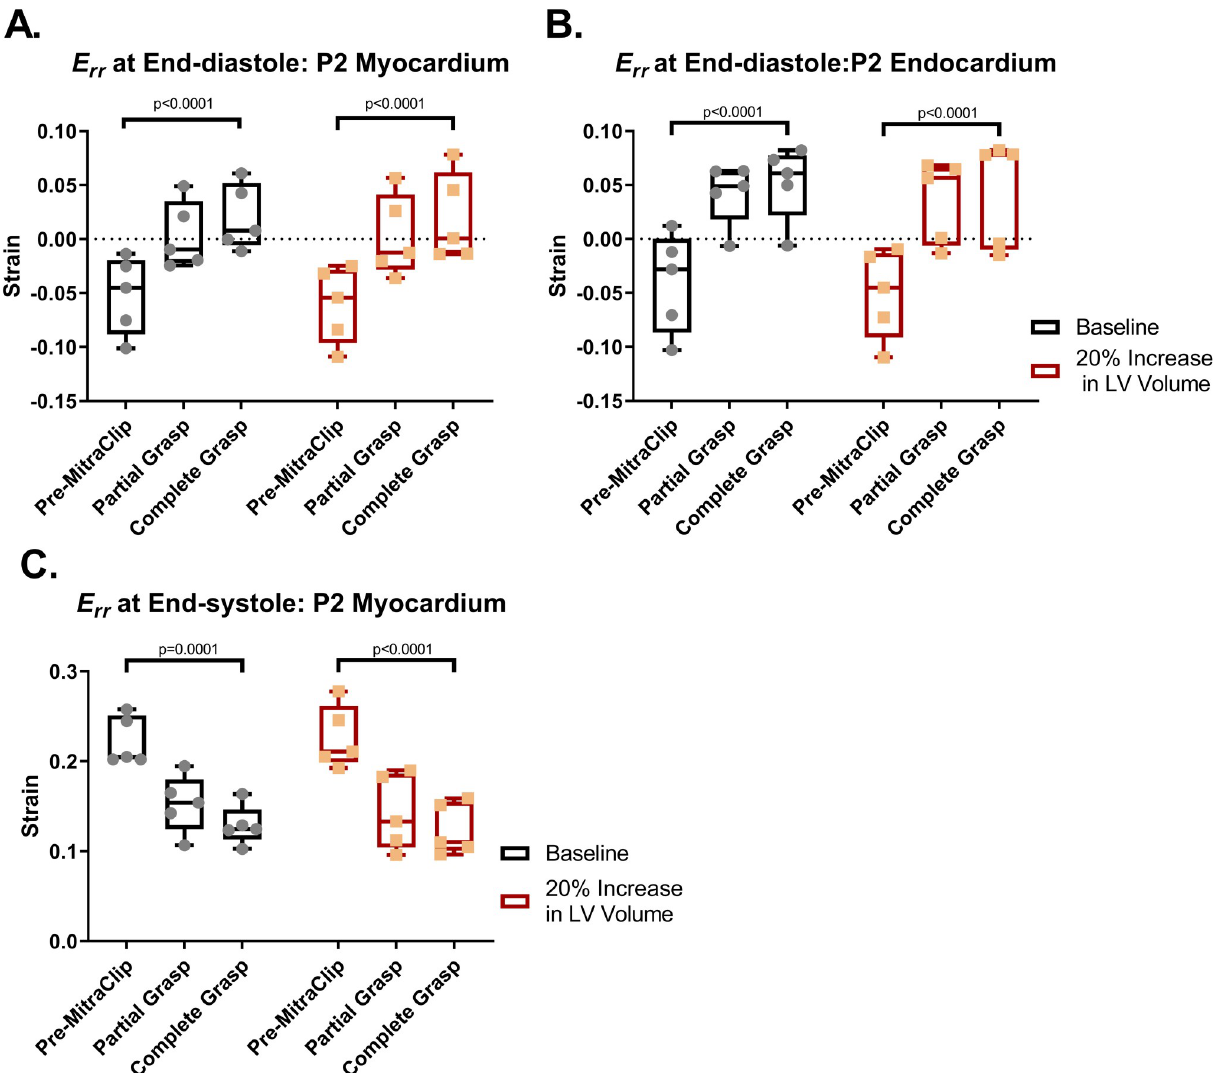
Fig 7. Radial strain, E_rr , after simulated partial and complete grasp MitraClip in the P2 sub-valvular myocardium at end-diastole (A), P2 sub-valvular endocardium at end-diastole (B) and P2 sub-valvular myocardium at end-systole (C) respectively. Err before and after MitraClip is relative to the pre- procedure unloaded